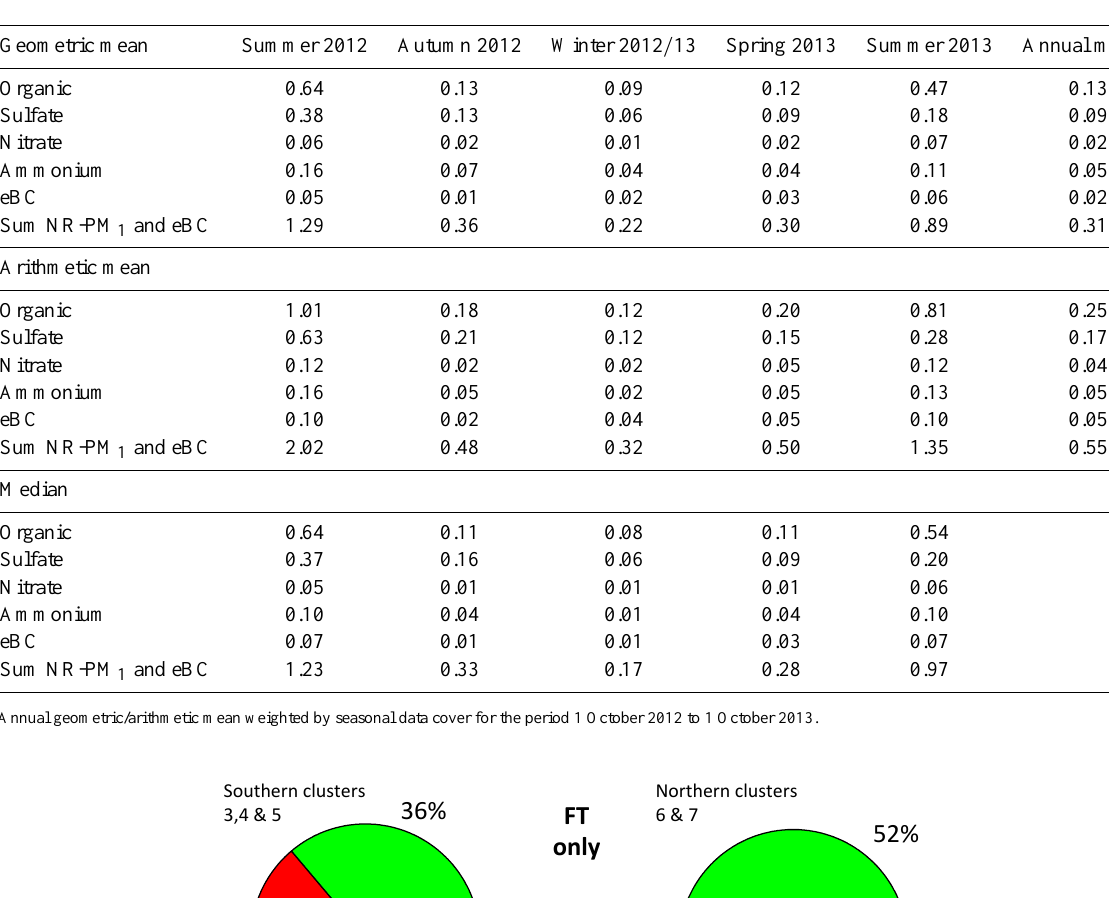
Table 1. Mean and median concentrations in µgm − 3 during each season.